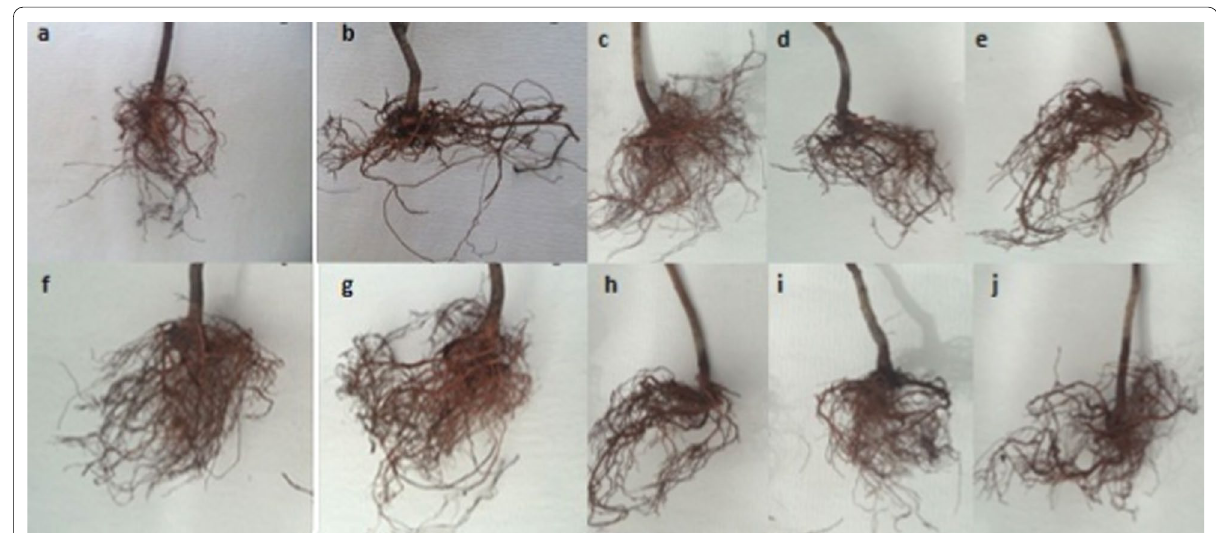
Fig. 4 Peach plants roots three months after inoculation with Pythium ultimum and their treatment: uninoculated control ( a ), inoculated control ( b ), Aspergillus candidus A5 A. niger A10 ( c ), Trichoderma harzianum T10 ( d ), A. candidus A5 ( e ), A. niger A10 ( f ), Bacillus subtilis (B) ( g ), T. harzianum T9 ( h ), + T. harzianum T10 B ( i ) and T. harzianum T9 T. harzianum T10 ( j + +